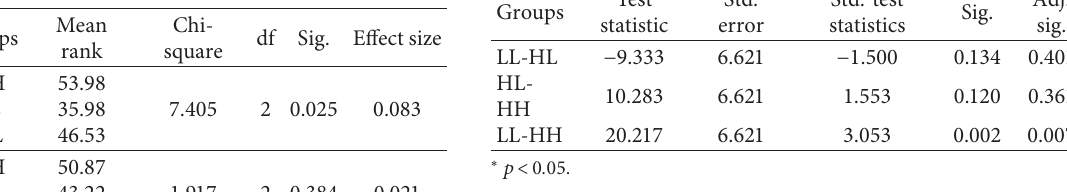
Table 4: Result of the Kruskal–Wallis H test for writing accuracy and fluency in post-test.